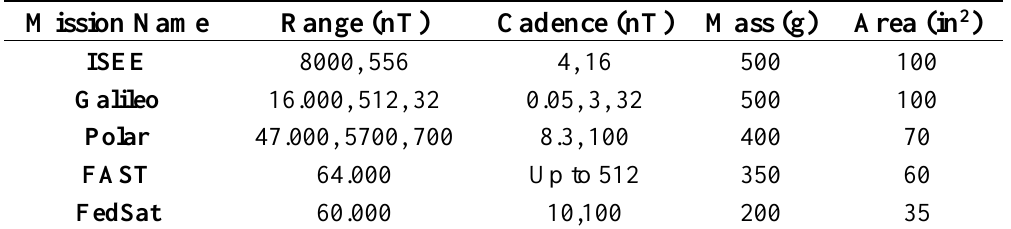
Table 2. Comparison between fluxgate magnetometers used in different